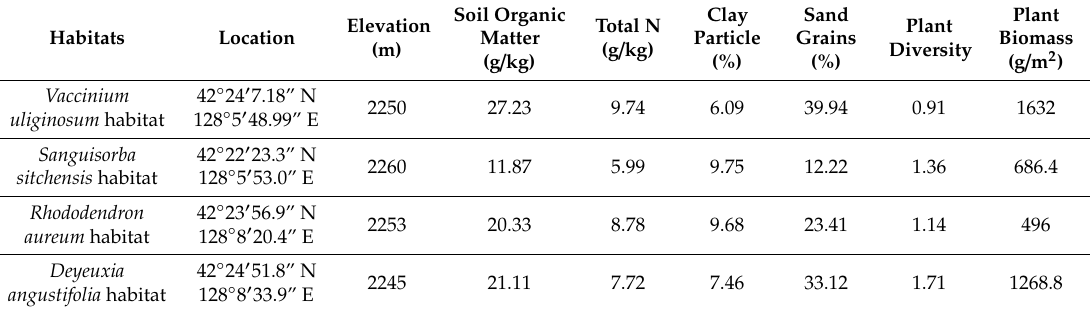
Table 1. Geographical information, soil and vegetation characteristics of the habitats.